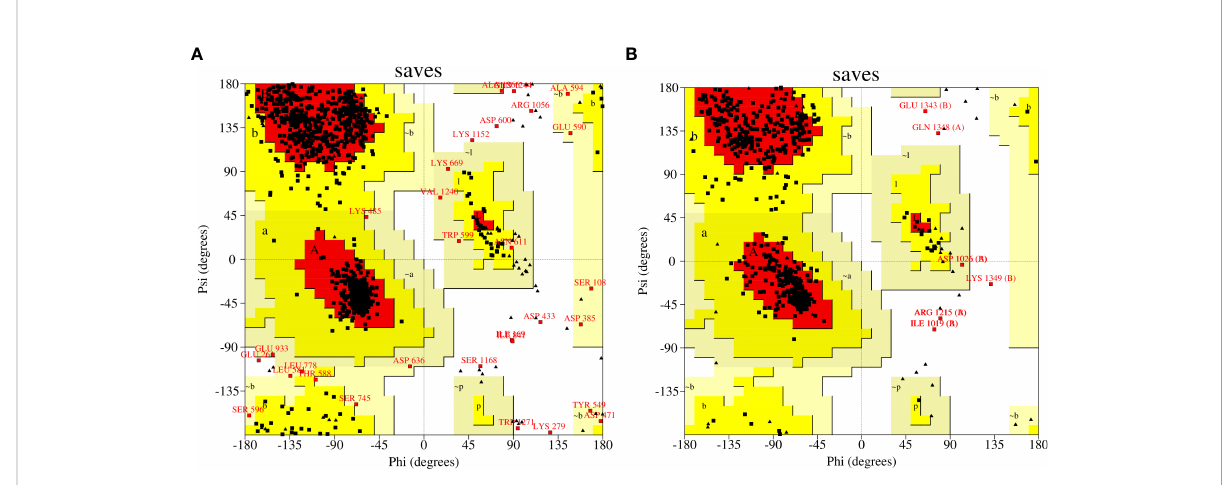
FIGURE 3 Mapping of amino acid residues ’ coordinates of modelled ACCase CT-domain of (A) P. minor and (B) T. aestivum on Ramachandran